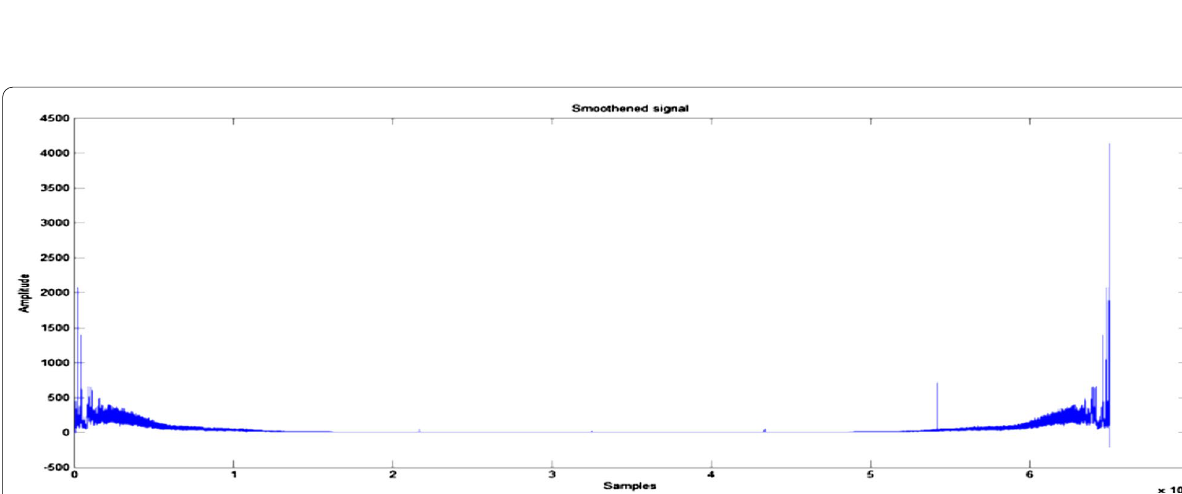
Fig. 11 Smoothened signal by FIR filter: Figure represents low-pass filtered signal with the Kaiser window having normalized cutoff frequency